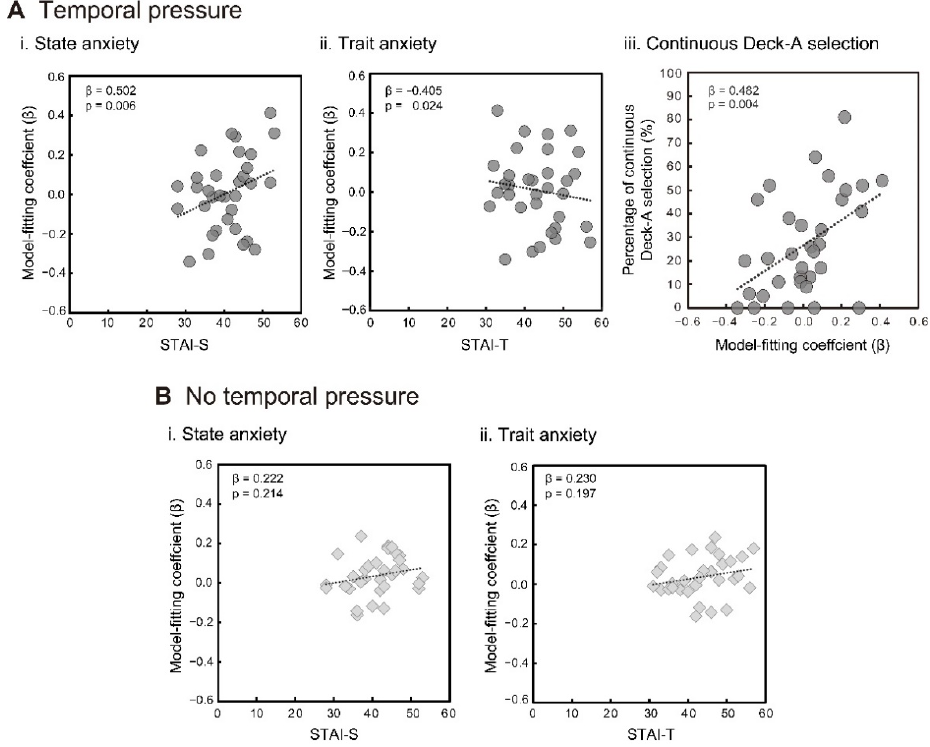
Figure 4. Relations between the participants’ anxiety scores (STAI-S and STAI-T) and their model fitting coefficients ( β ) for the temporal pressure condition ( Ai , Aii ) and the no temporal pressure con- dition ( Bi , Bii ) ( n = 33). Relation between continuous Deck A selection and model fitting coefficients for the temporal pressure condition ( Aiii ). Beta coefficients were calculated via multiple regression analyses, while the original data were plotted in each